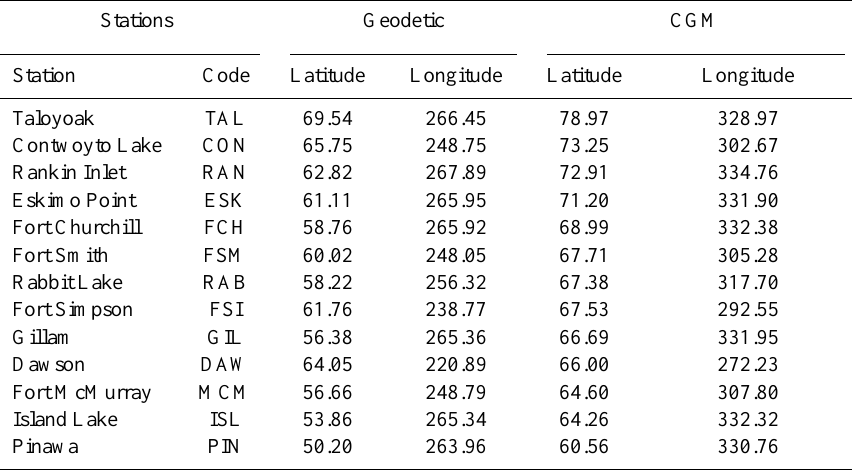
Table 1. The coordinates of the CANOPUS magnetometer stations used in this study. The corrected geomagnetic coordinates (CGM) were calculated for the 2000 epoch at an altitude of 120km using the International Geomagnetic Reference Field converter at http://nssdc.gsfc.gov/space/cgm/cgm.html